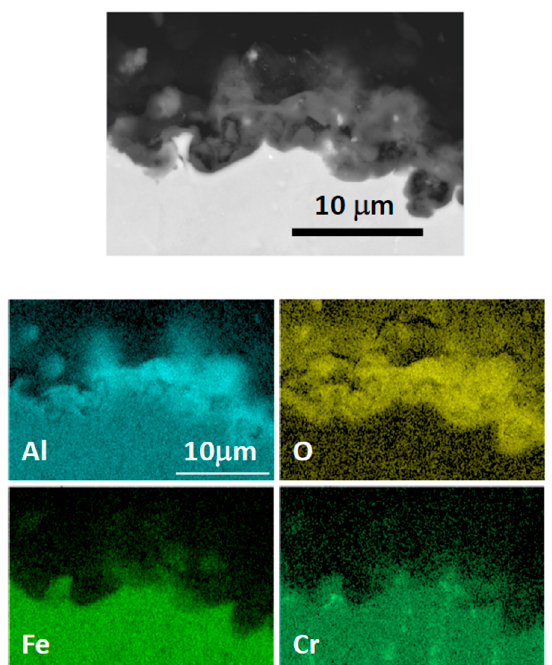
Figure 16. FESEM cross sections of the scale found at the surface of aluminide-coated HT347HFG exposed to steam at 700 °C, at atmospheric pressure and at 25 MPa.